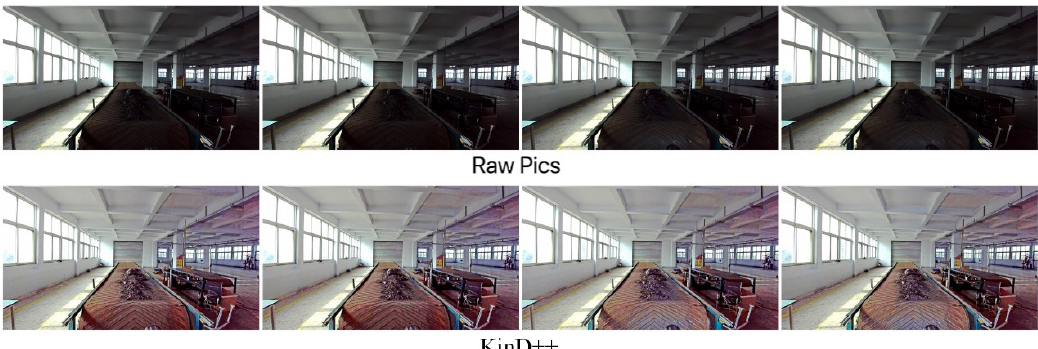
Figure 18. Enhancement of KinD++ algorithm on daytime backlight image.